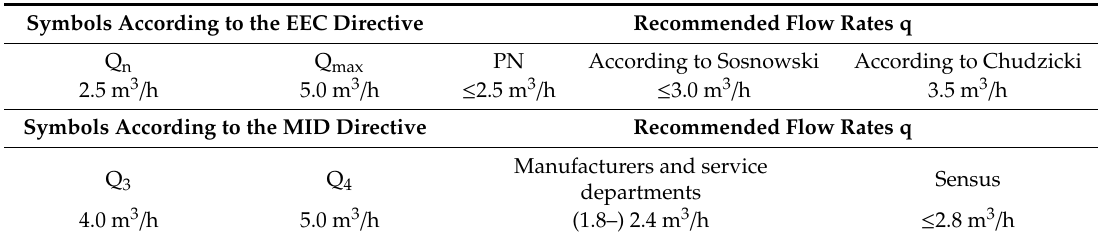
Table 2. Comparison of volumetric water flow rates for the water meter DN 20 mm. Symbols According to the EEC Directive